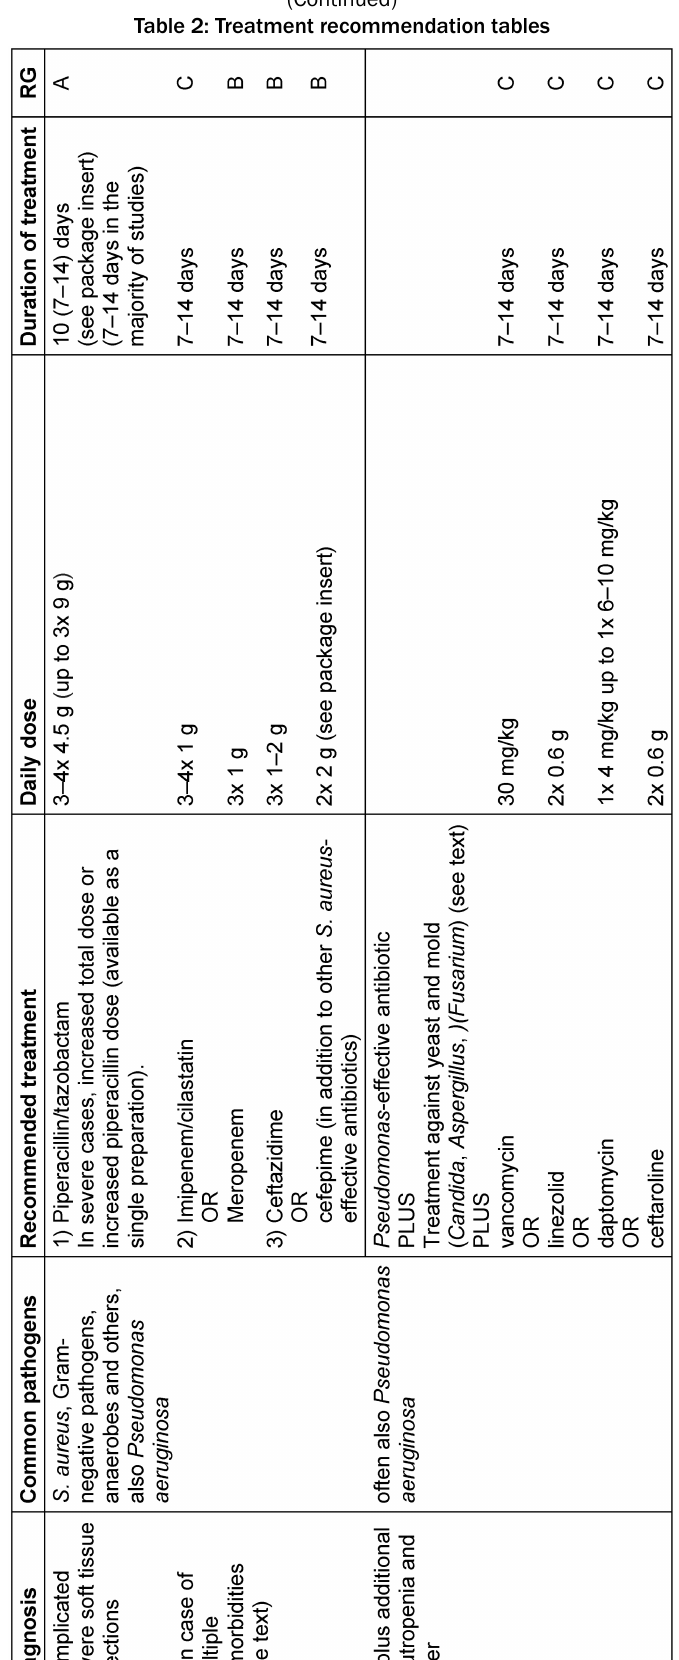
Table 2: Treatment recommendation